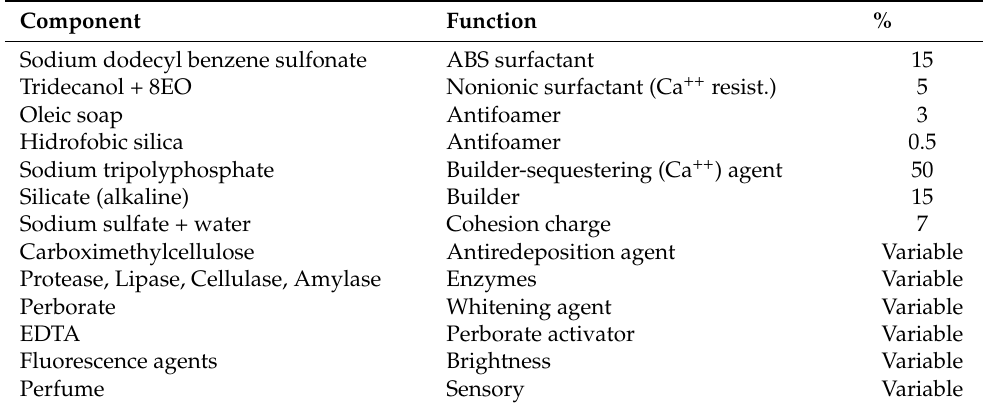
Table 3. Typical formulation example for a powder detergent